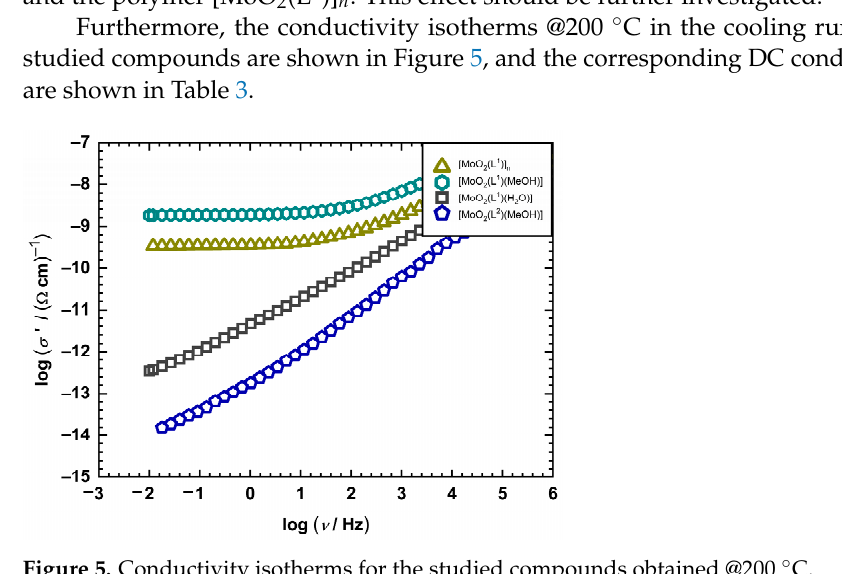
Figure 5. Conductivity isotherms for the studied compounds obtained @200 °C. Table 3. DC conductivity values for all compounds measured @200 °C in the cooling run. Compounds